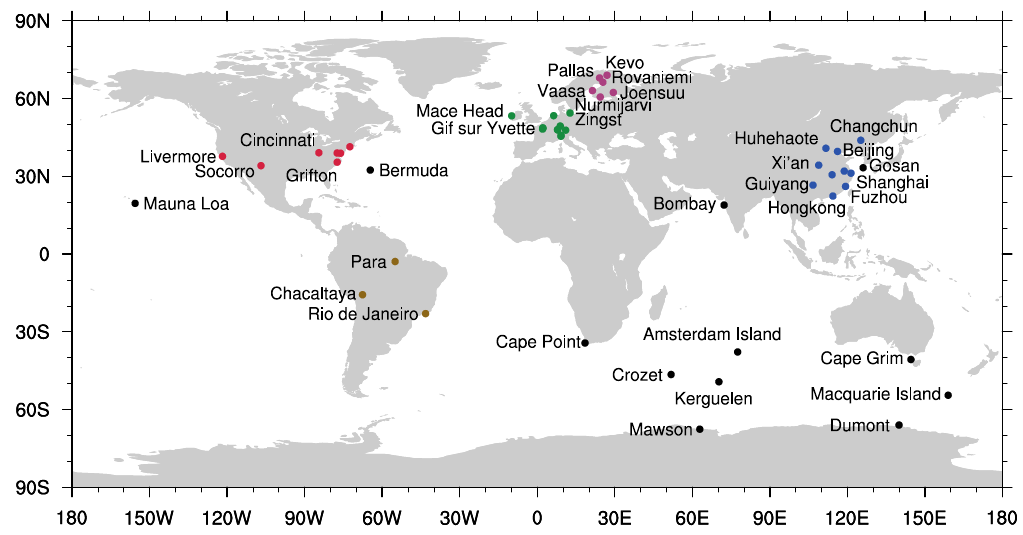
Fig. 3. Location of surface radon measurements used in this study. See Table 2 for further information of the sites. Colors indicate observational sites in the five different regions that are analysed separately in Fig. 5.